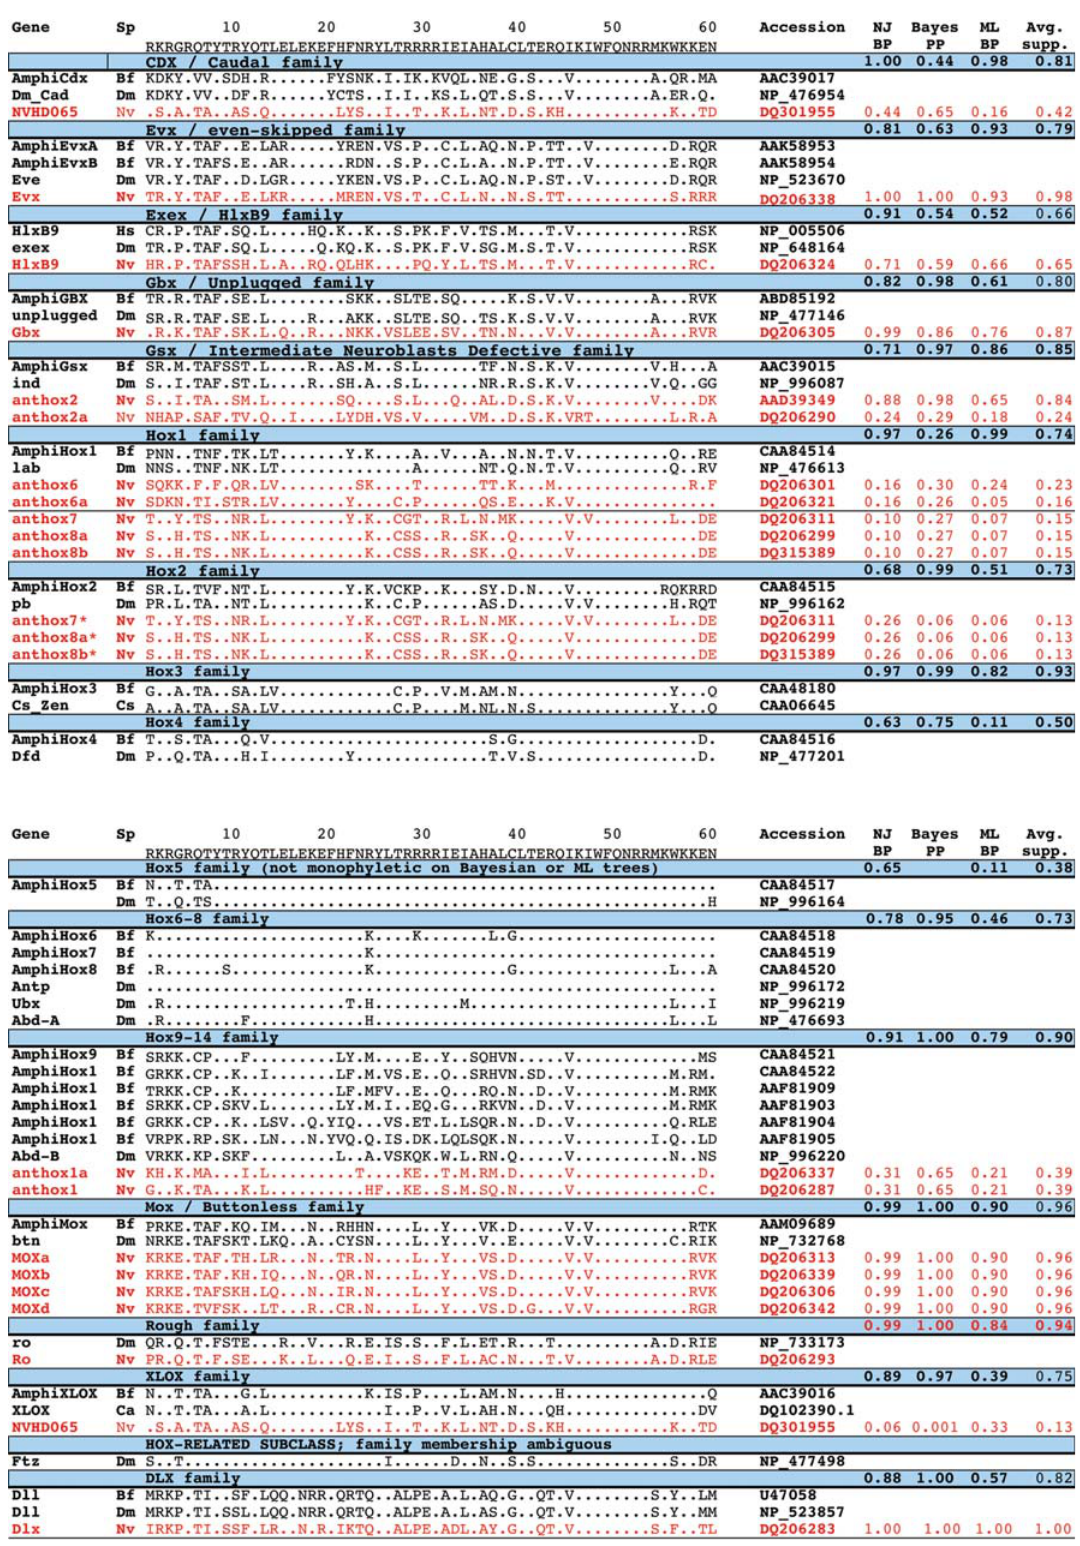
Figure 1. Alignment of homeodomains included in the phylogenetic analyses. All sequences are aligned to the Drosophila Antennapedia homeodomain. Each Nematostella sequence is grouped with putative bilaterian homologs. The degree of statistical support (bootstrap proporation [BP] or posterior probability [PP]) for each of these homology assignments is indicated separately for the neighbor-joining (NJ), Bayesian (Bayes), and maximum-likelihood (ML) trees. The average statistical support for each grouping is indicated in the far right column (NJ-BP + Bayes-PP + ML-BP/3). The dataset is available in Phylip format as Figure S12.